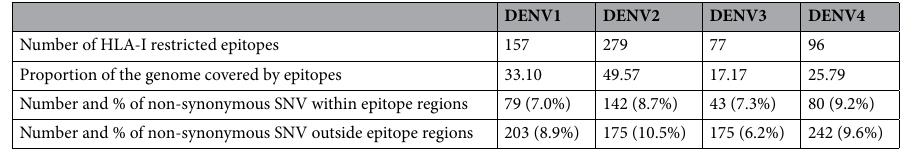
Table 1. Summary of viral diversity within and outside epitope